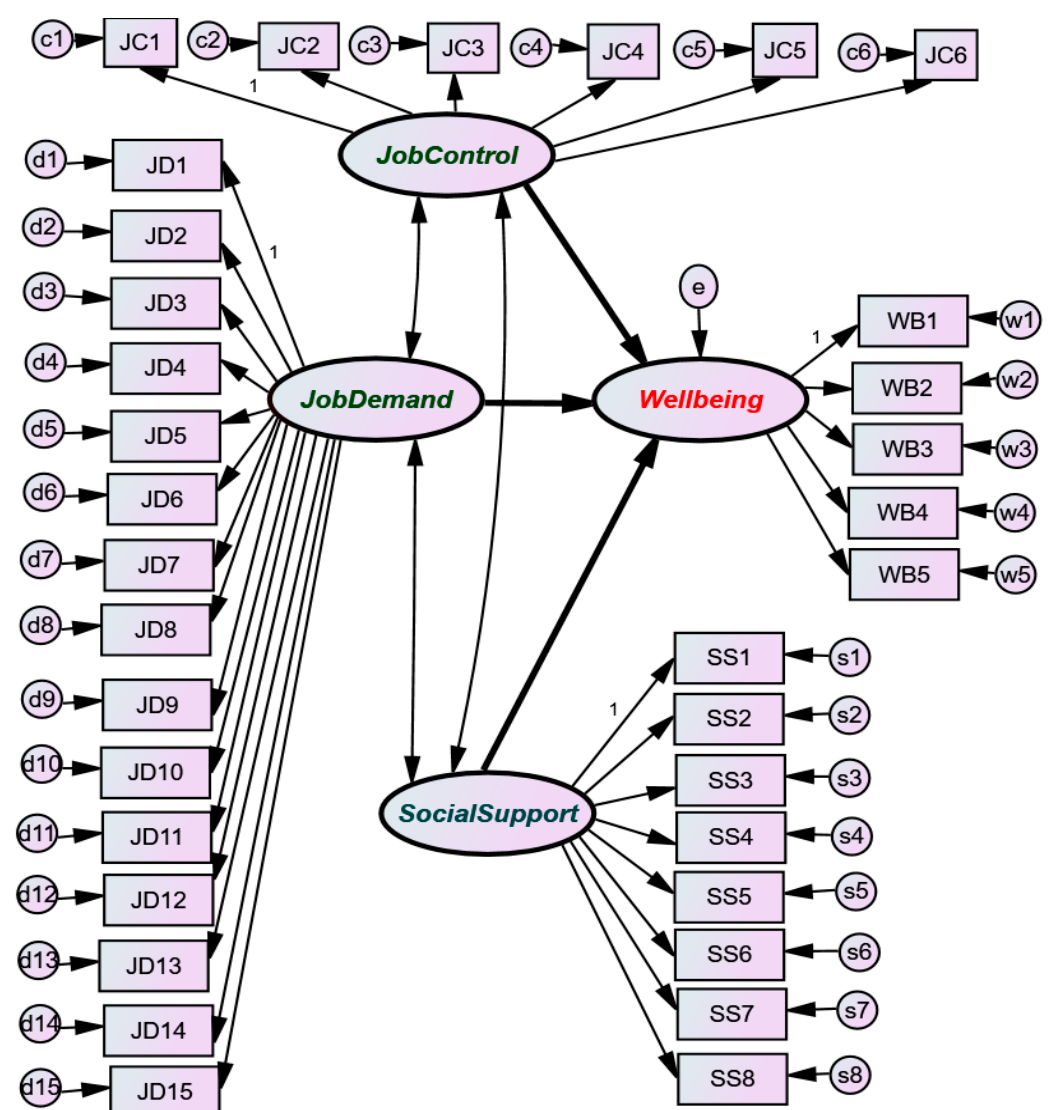
Figure 2. Structural Model.